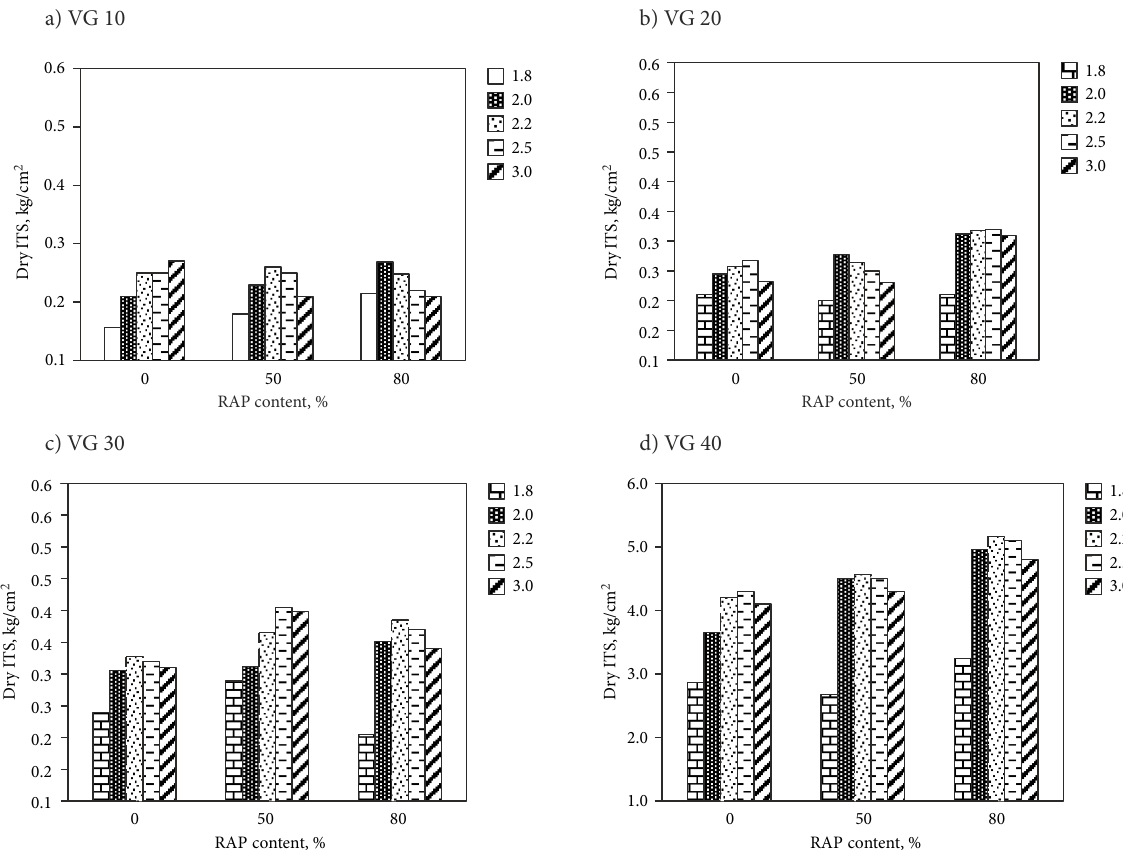
Figure 4. Variation of Indirect Tensile Strength with Reclaimed Asphalt Pavement percentage and Foamed Bitumen